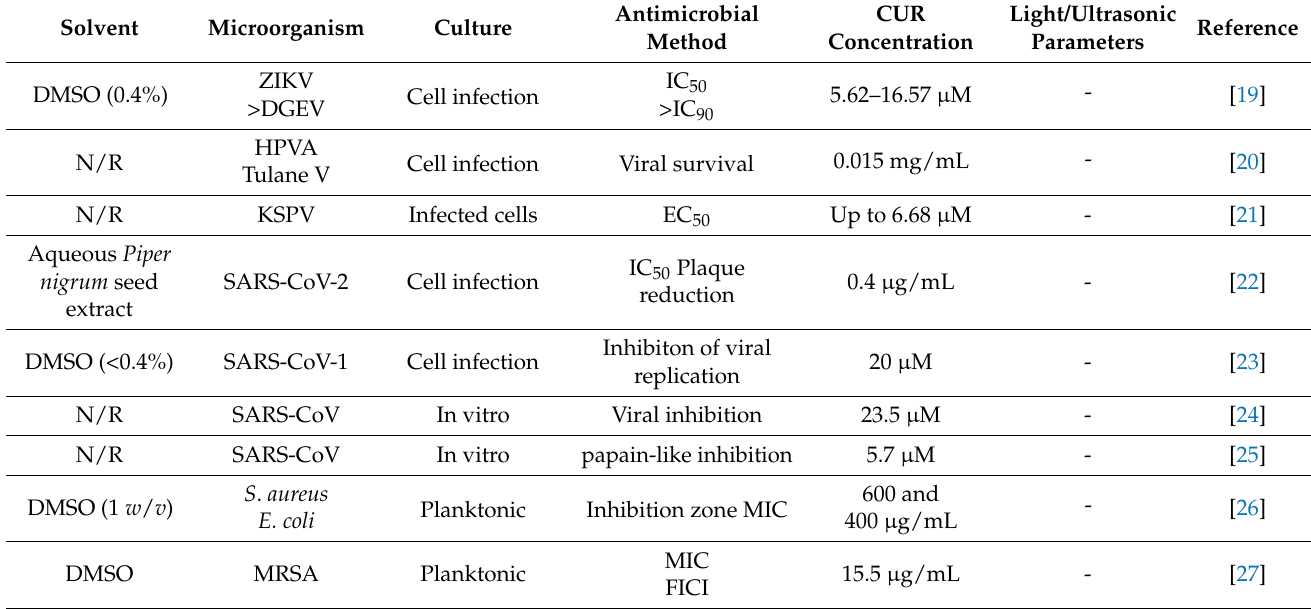
Table 1. In vitro and in vivo studies using free CUR and curcuminoids as